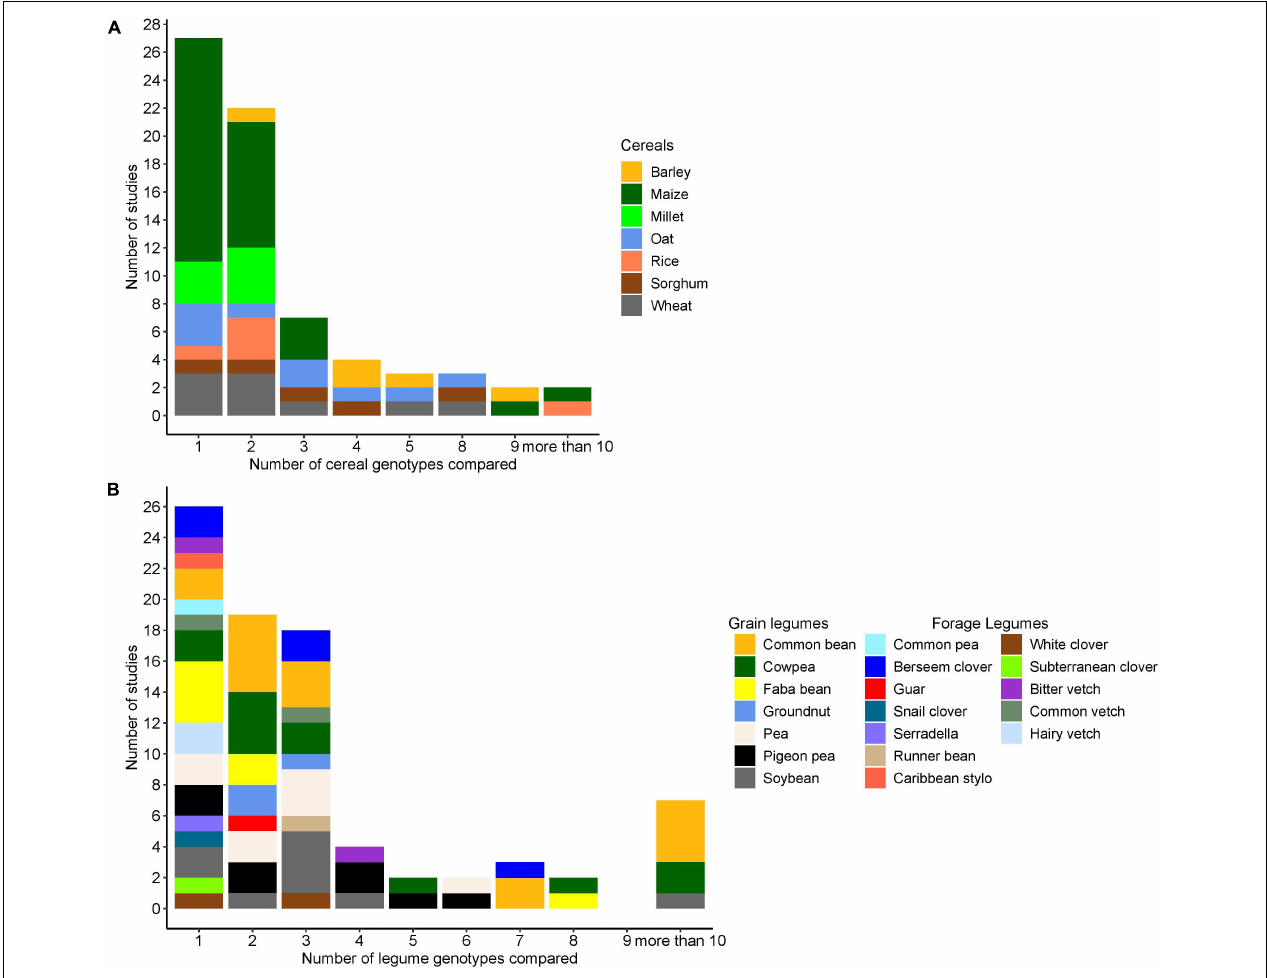
FIGURE 1 | (A) Number of cereal genotypes evaluated in combination with legume species (each combination was categorized based on the cereal species). (B) Number of legume genotypes evaluated in combination with cereal species (each combination was categorized based on the legumes species). In both cases, if one genotype of one partner is evaluated, the other partner had at least 2